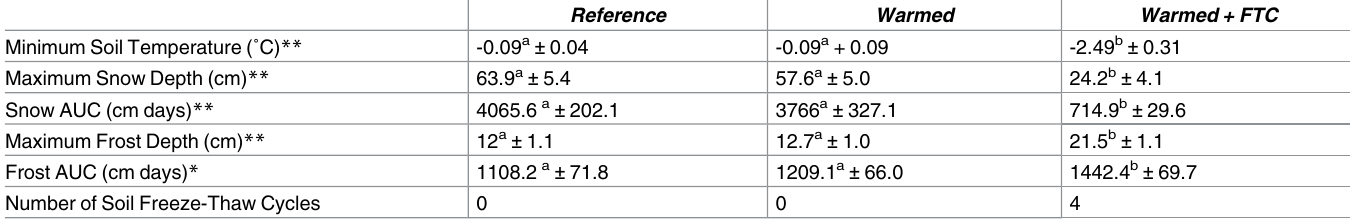
Table 2. Winter environmental variables by experimental treatment averagedacross both winters of 2013/2014 and 2014/2015. Minimum soil tem- peratures at 10 cm depth shown below. Valuesare means with standarderror ( * P < 0.05, ** P < 0.0001 for comparisons amongtreatments; degreesfree- dom = 2). Distinct letters within a row indicatestatistically significantdifferences